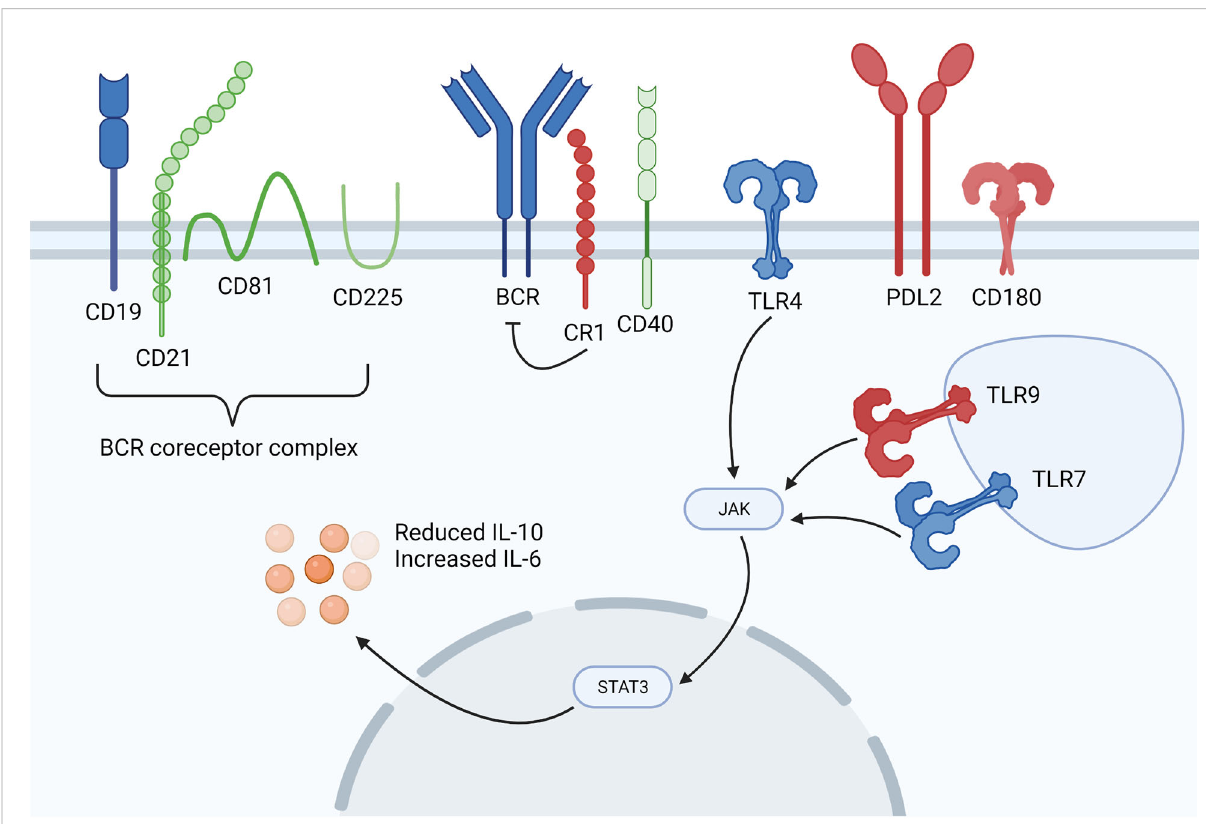
FIGURE 2 Dysregulated B cell signalling in SSc patients. Overexpressed molecules are shown in blue, underexpressed molecules are shown in red and those shown in green are of interest in SSc, but are neither up or downregulated. SSc B cells are in a hyperactive state marked by differential expression of the BCR coreceptors CD19 and inhibitory CR1. TLR signalling is augmented through differential TLR4, TLR7, TLR9 and CD180 expression, whilst increased levels of serum soluble PD-1 and PD-L2 inhibit the PD-1 and PD-L2 interaction between T and B cells. Figure created with